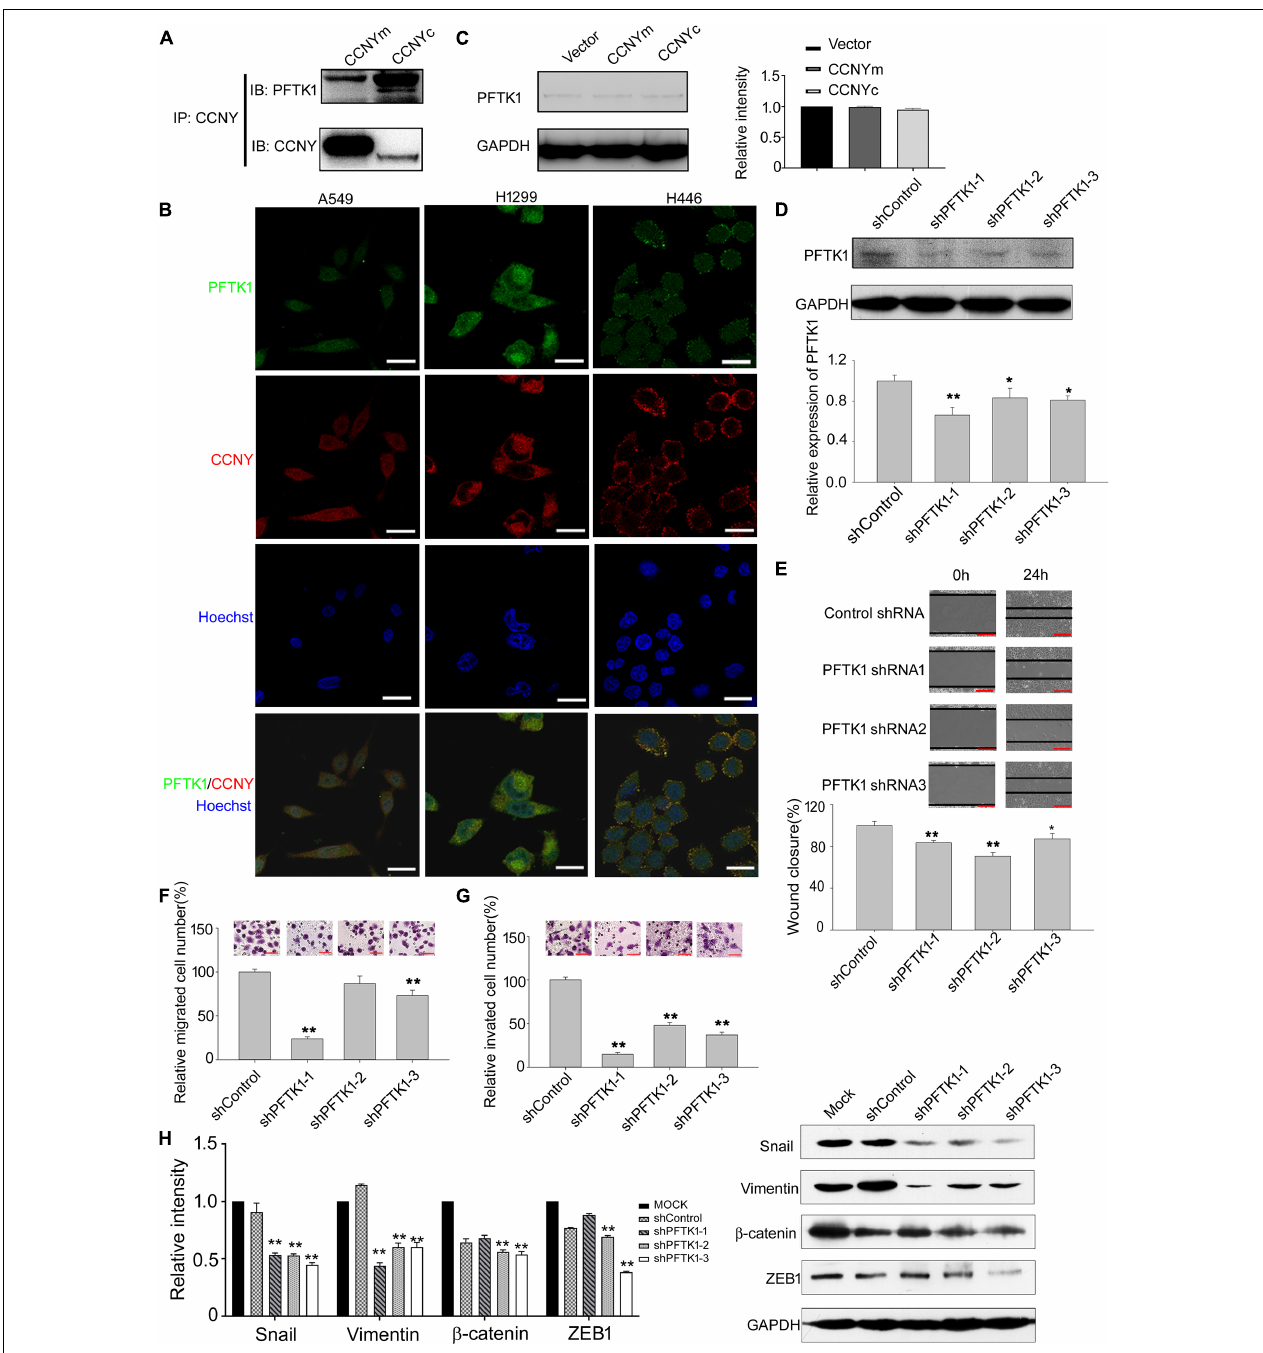
FIGURE 5 | PFTK1 was involved in CCNYc signal pathway. (A) Co-IP assay was done using H1299 CCNYc and H1299 CCNYm cells. Co-IP demonstrated the binding ability of CCNY and PFTK1. (B) Co-localization of PFTK1 and CCNY in human lung cancer cells. PFTK1 and CCNY were marked by immunofluorescence staining (IF). Bars represent 10 µ m. (C) The level of PFTK1 in CCNY up-regulated H1299 cells was examined by WB (left panel) and quantified by gray analysis (right panel). (D) H1299 CCNYc cells were infected by recombinant lentivirus carrying shRNA targeting to PFTK1 mRNA. PFTK1 mRNA expression was inhibited by PFTK1-shRNA1-3. The level of PFTK1 was detected by WB (upper panel) and high-content cell analysis (lower panel). * p < 0.05 vs. shControl H1299-CCNYc cells, ** p < 0.01 vs. shControl H1299-CCNYc cells ( t -test). (E) Wound healing assay performed with PFTK1 downregulation cells. The migration activity is expressed as mean ± SEM. ** p < 0.01 vs. H1299-CCNYc cells expressing control shRNA ( t -test, N = 3). (F,G) Transwell migration assay and invasion assay of H1299. The data are shown as mean ± SEM. ** p < 0.01 vs. H1299-CCNYc cells expressing control shRNA ( t -test, N = 3). Bars represent 200 µ m. (H) Expression of ZEB1, vimentin, β -catenin and snail and was examined by WB (right panel). The left panel, the level of proteins was quantified by gray analysis. * p < 0.05 vs. H1299-CCNYc cells expressing control shRNA, ** p < 0.01 vs H1299-CCNYc cells expressing control shRNA ( t -test).